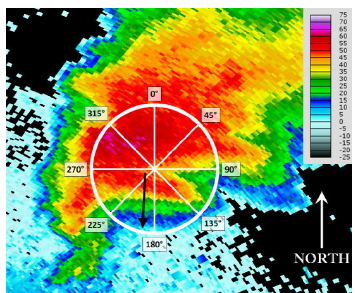
Figure 1. Method used to estimate the supercell forward flank angle, a necessary SPORK input. Example is Z HH from a tornadic supercell in the domain of the Dodge City, Kansas, WSR – 88D (KDDC) at 0005 UTC on 19 May 2013. Legend indicates Z HH values (dBZ). Circle with angles marked indicates meteorological direction (north is 0°). Black arrow is the direction of the forward – flank